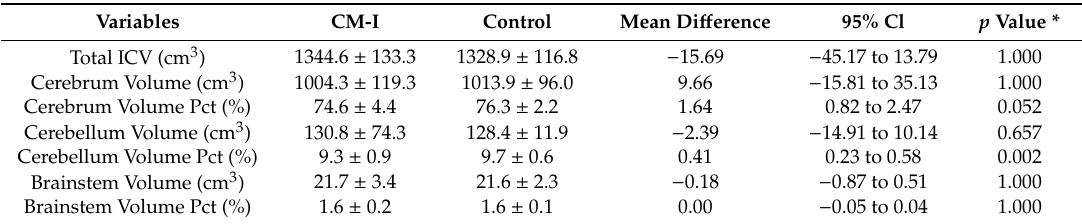
Table 1. Comparison of total intracranial, cerebrum, cerebellum, and brainstem volumes and volume percentages between Chiari type I malformation (CM-I) and control